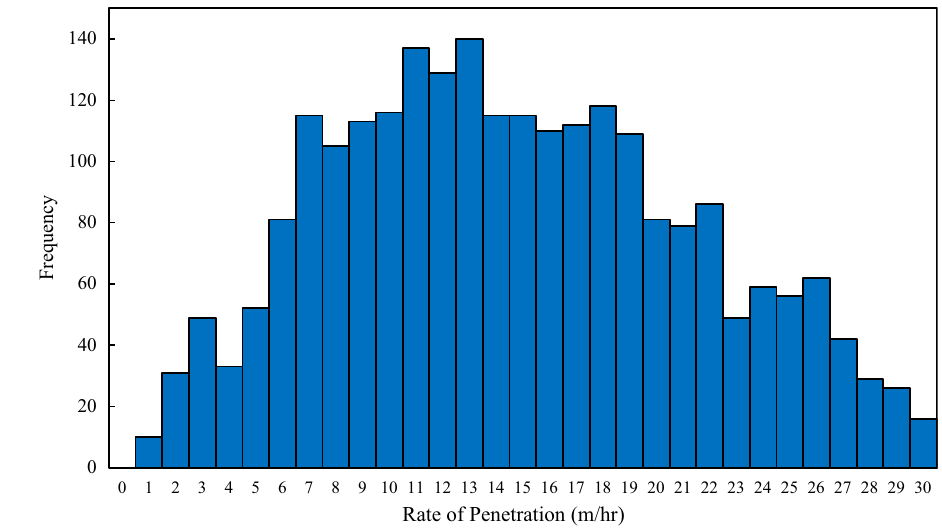
Fig. 4 ROP histogram after filtration (2376 data points)